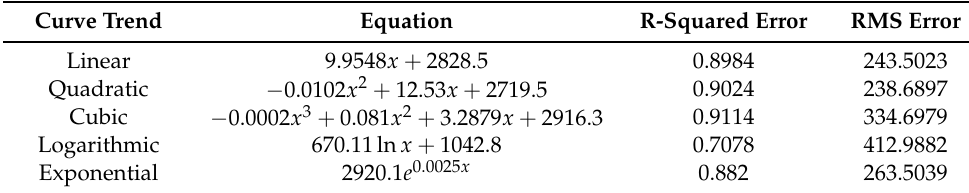
Table 1. Best fit curve and RMSE for Dr. Reddy’s Lab (Pharma sector).